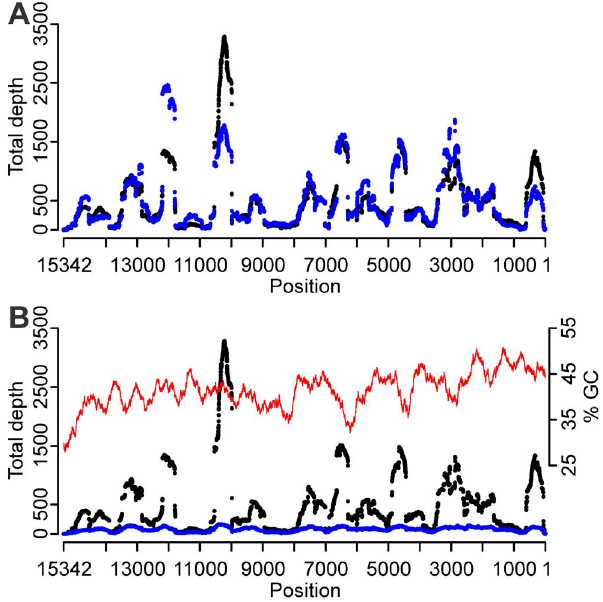
Figure 3. Effect of RNA fragmentation and GC-content on sequence depth distribution. (A) Fragmented (blue) and unfrag- mented (black) RNA, random amplified with the FR20RV-6N SISPA primer. The X-axis represents the position on the APMV-8 genome. (B) Total (black) and unique (blue) depth distribution of the FR20RV-6N SISPA primer condition. At unique depth, reads with identical starts are omitted. Also positions GC-content (window size 401) of the APMV-8 genome is displayed (red).